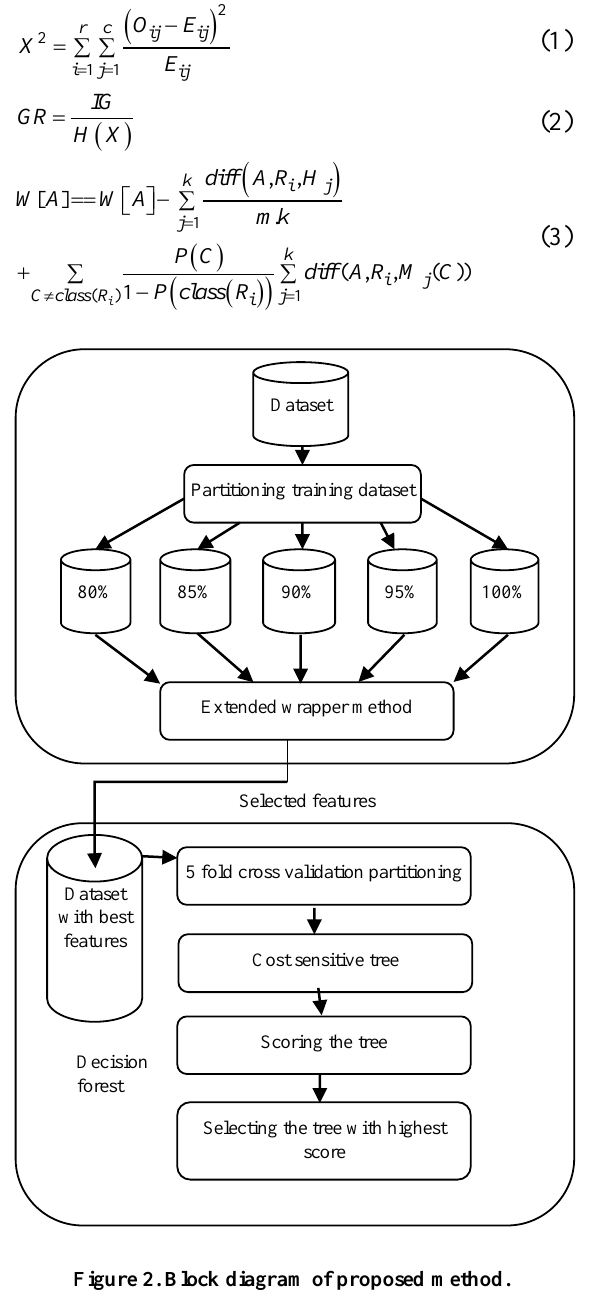
Figure 2. Block diagram of proposed